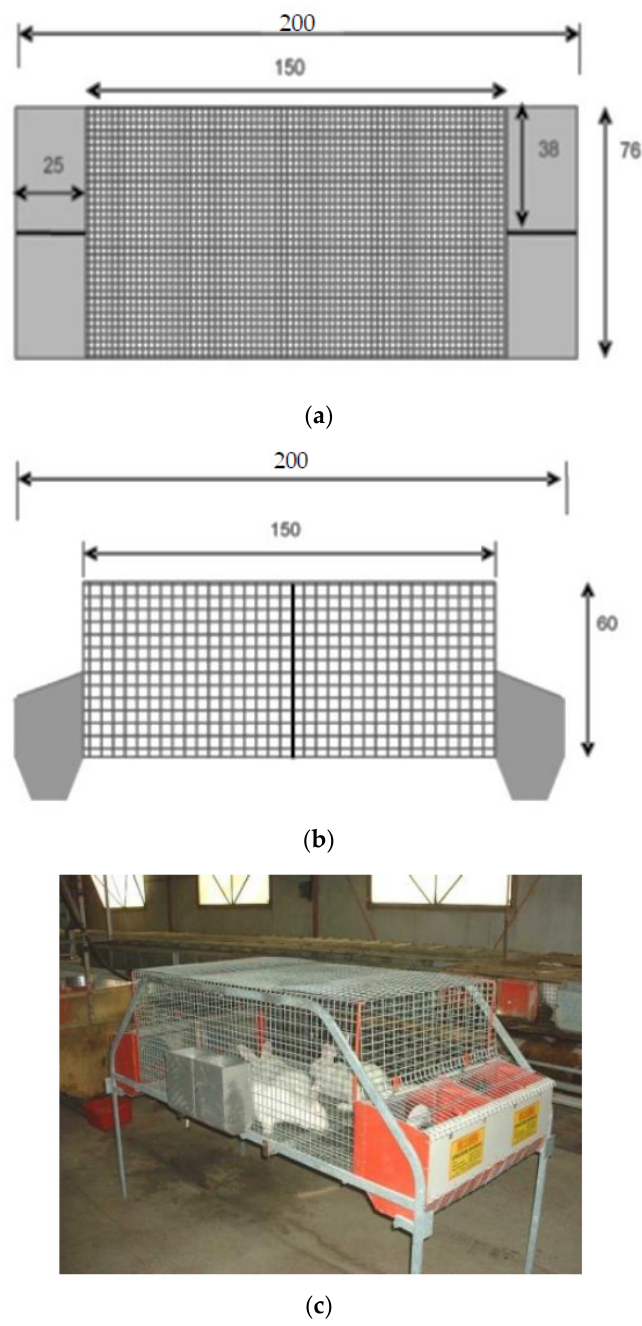
Figure 1. Dimensions (cm) of continuously grouped (C1) colony cage: ( a ) front view, ( b ) side view, ( c ) lateral